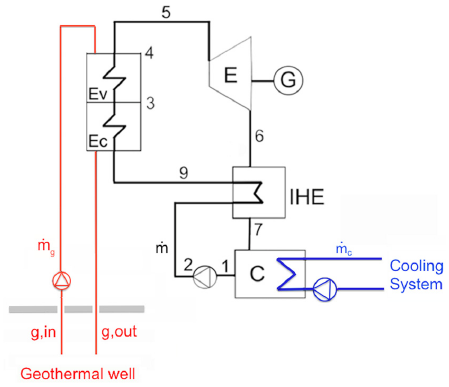
Figure 2. Scheme of geothermal Organic Rankine Cycle (ORC) system. Energies 2018 , 11 , x